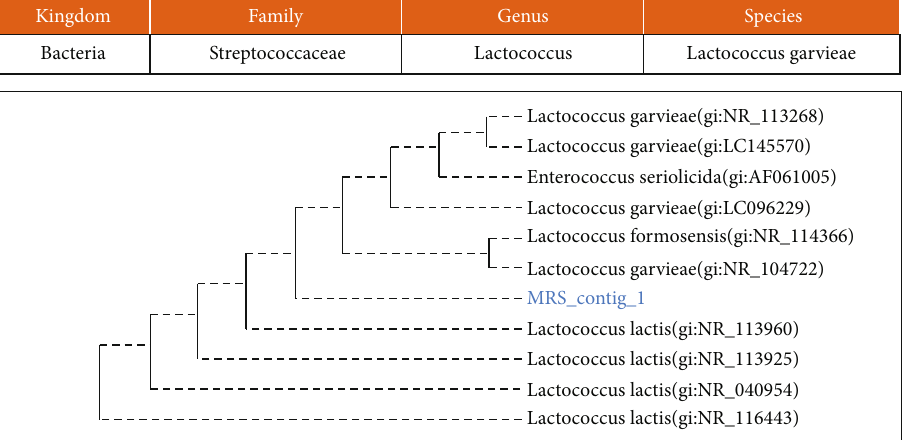
Figure 5: The phylogenetic study of isolate MRS-1/MRS AKP.